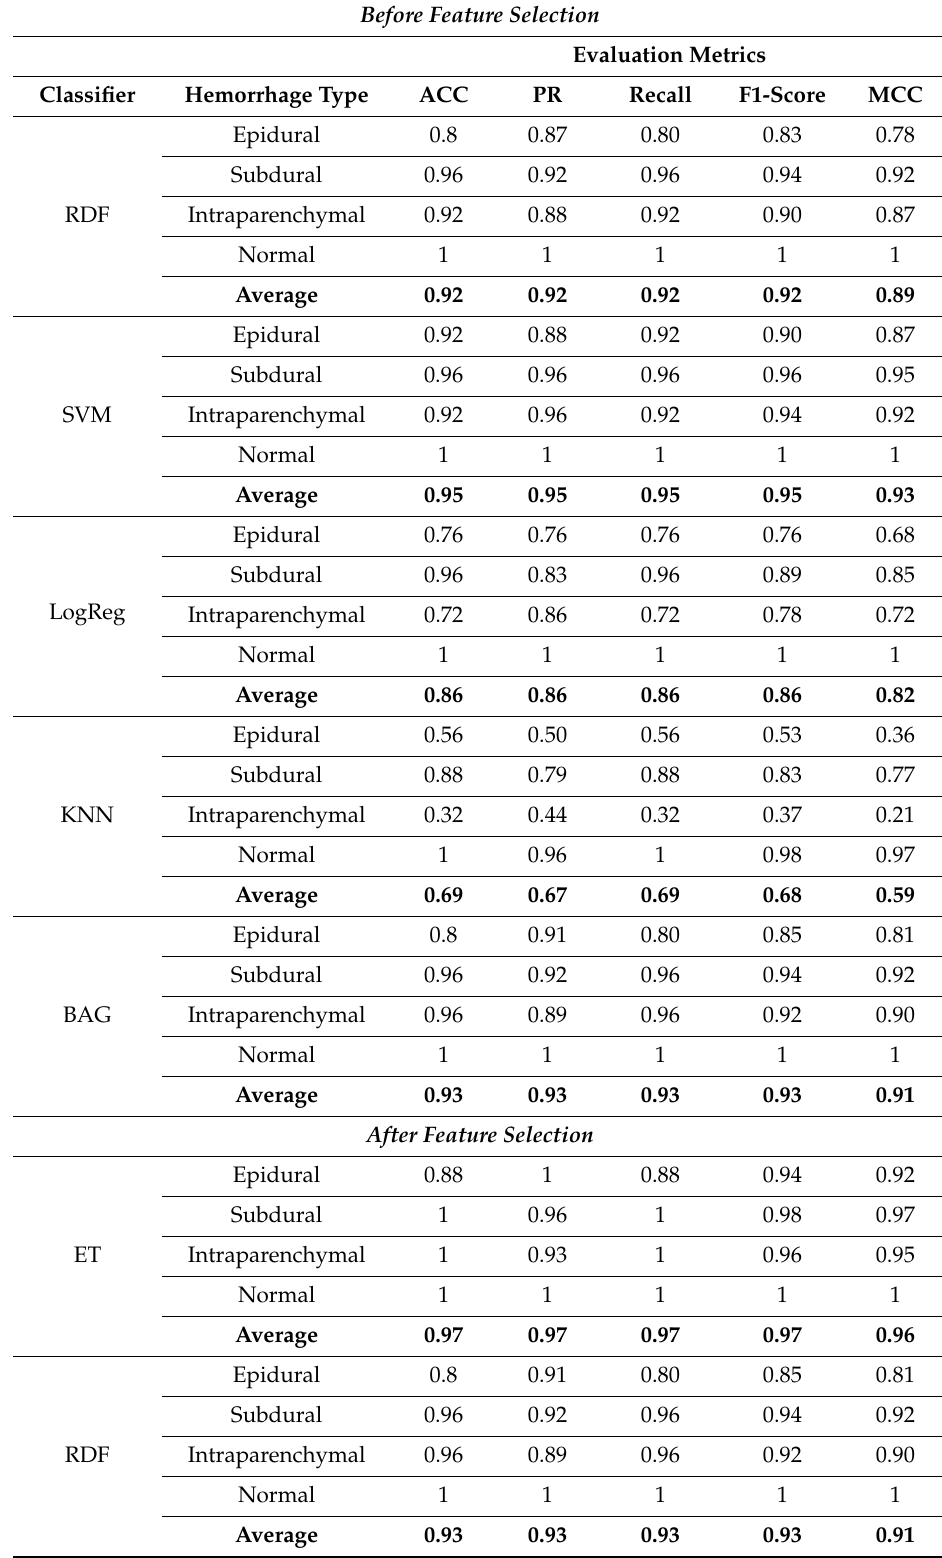
Table A1. Cont . Before Feature Selection Evaluation